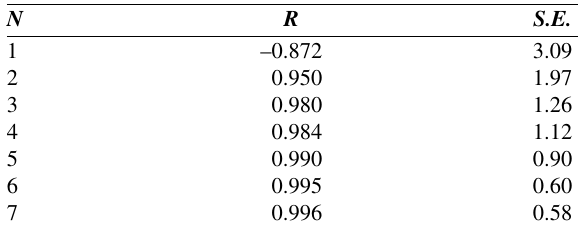
Table 2. Correlation of boiling points of octanes to the best combi- nation of N matrix